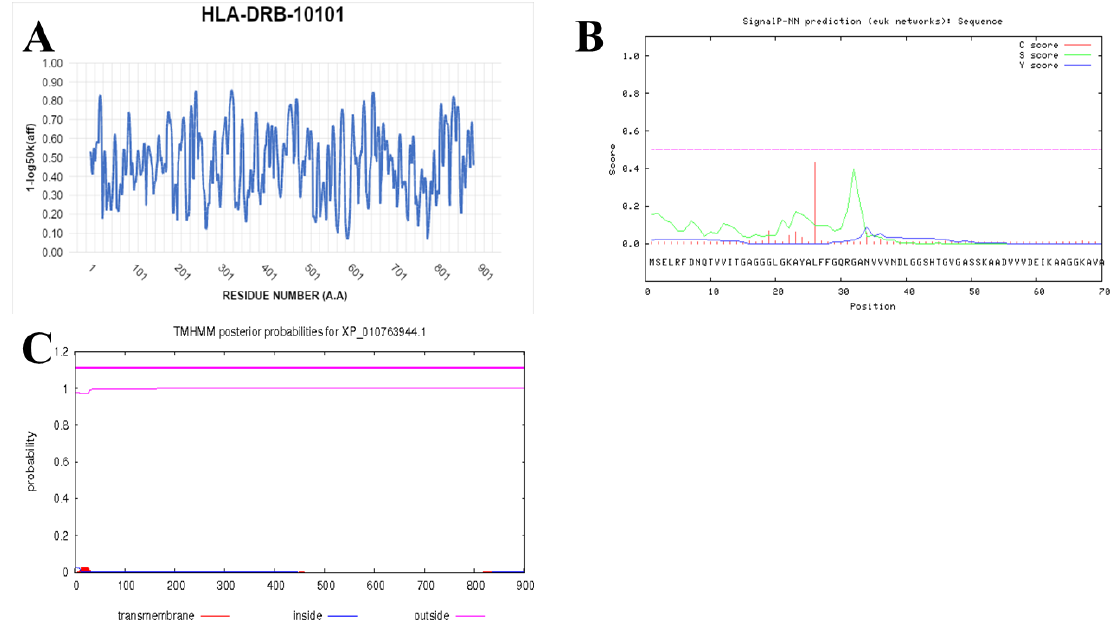
Figure 3. Analysis of the interaction of the peroxisomal protein hydratase dehydrogenase epimerase (GenBank: PADG_06851) by integrating different algorithms. ( A ) Signal peptide prediction (signal peptide). ( B ). Prediction of transmembrane regions (TMHMM). ( C ). Prediction of MHC II epitopes (NetMHCII).